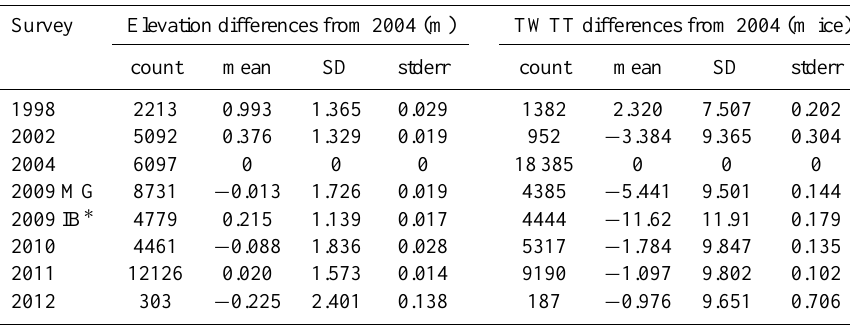
Table 3. Statistics of the differences between data from each survey and their nearest 2004 analogue, as shown in Fig. 4. TWTT is expressed as solid-ice thickness equivalent. Survey Elevation differences from 2004 (m) TWTT differences from 2004 (m ice) count mean SD